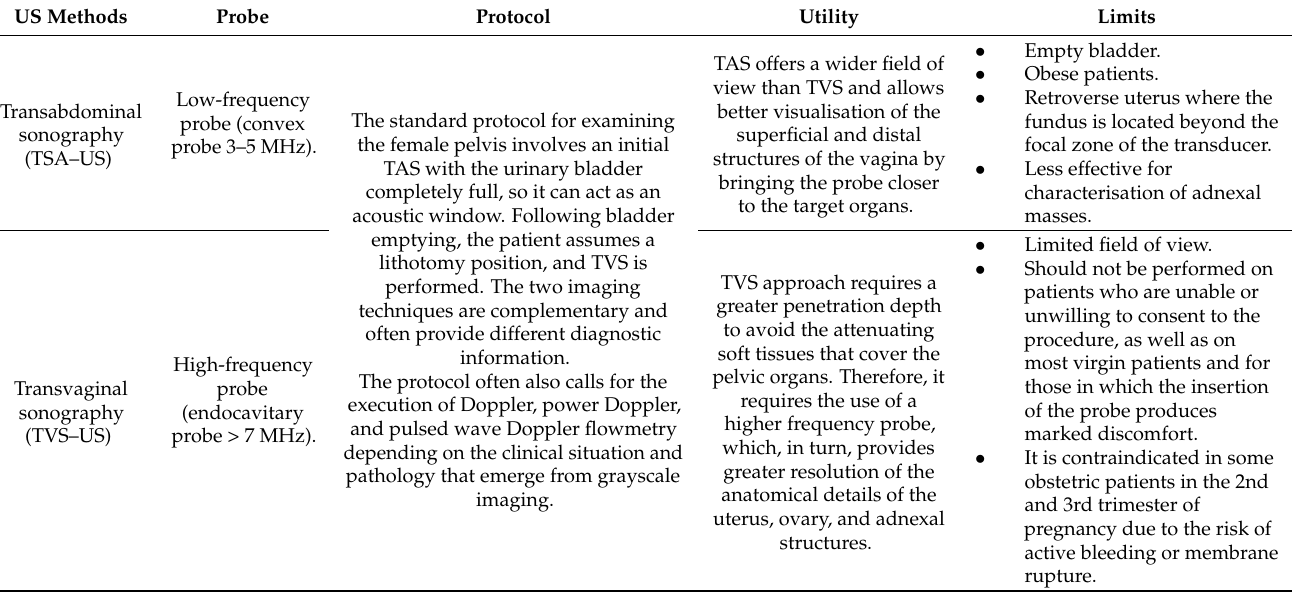
Table 1. TSA–US and TSV–US in comparison.